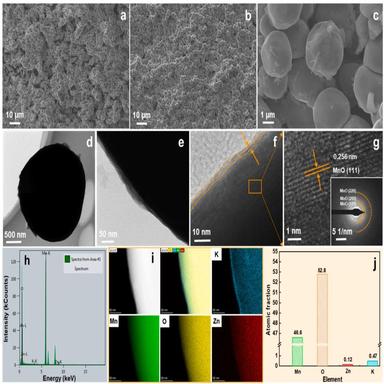
Characterization of MnO and MnO@ZnO particles. (a) SEM image of MnO, (b, c) SEM images of MnO@ZnO, (d–f) TEM images of MnO@ZnO, (g) HRTEM image of MnO@ZnO, inset showing the corresponding SAED pattern, (h) EDS of MnO@ZnO, (i) HAADF-STEM image and corresponding EDS mappings of MnO@ZnO, and (j) Atomic fraction in MnO@ZnO.